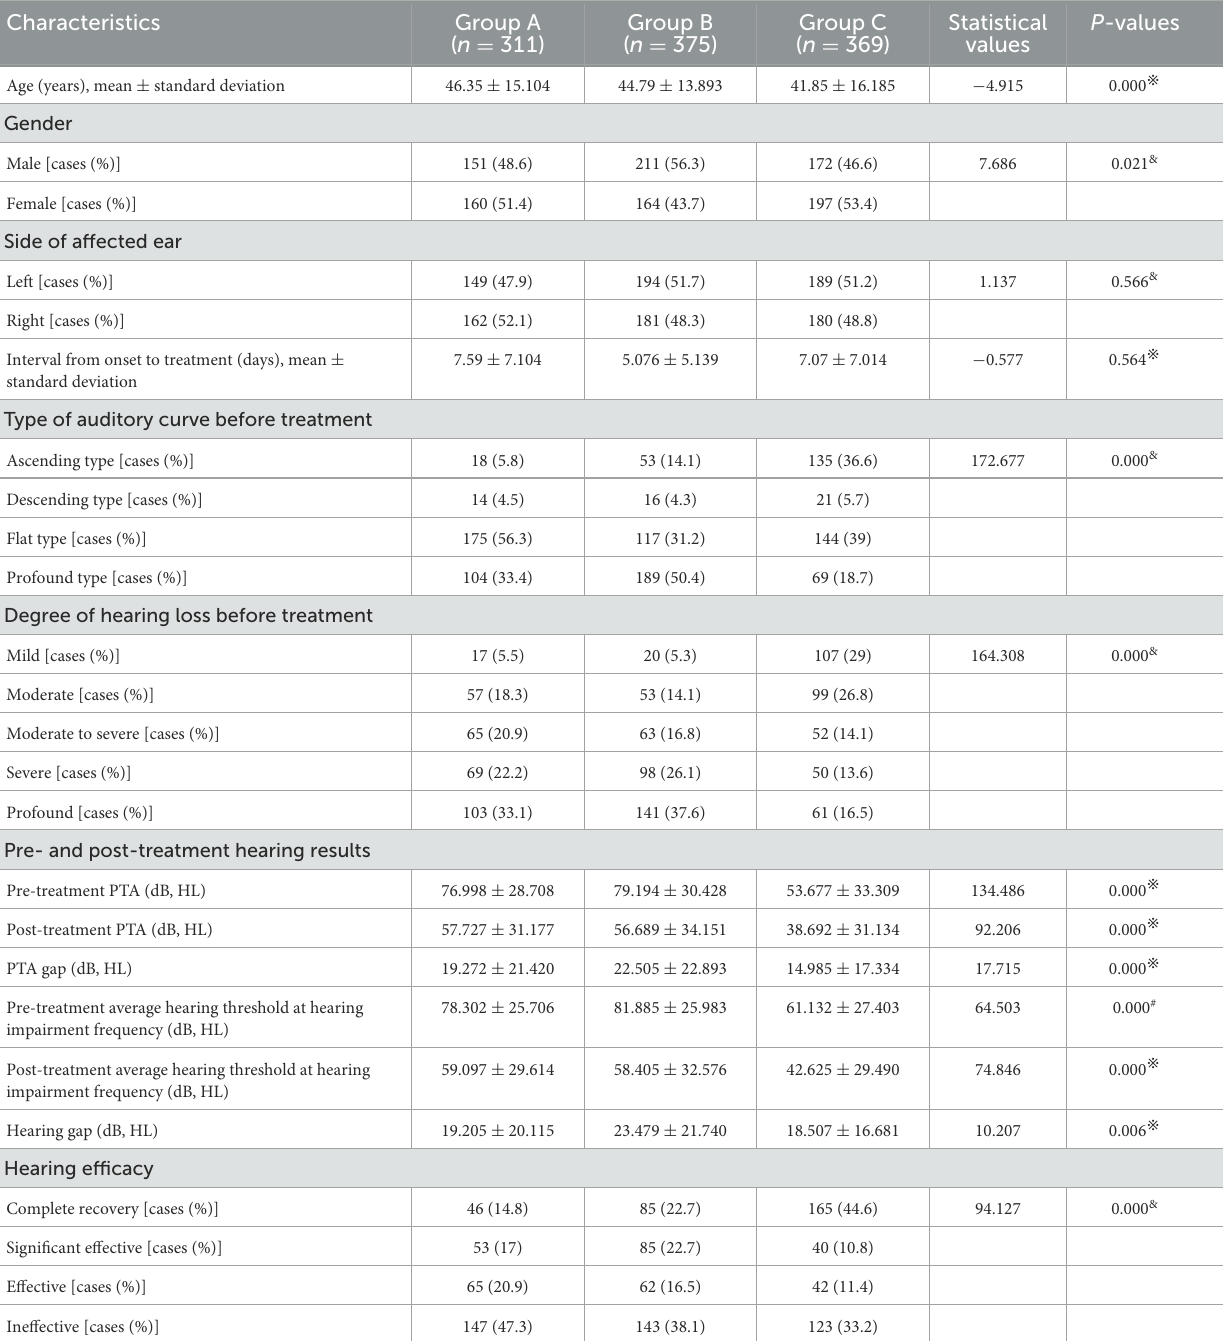
TABLE 3 Clinical characteristics and pre- and post-treatment hearing of patients of the three groups. Characteristics Group A